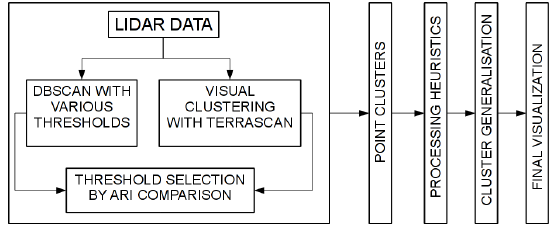
Figure 3: The processing pipeline for the LiDAR